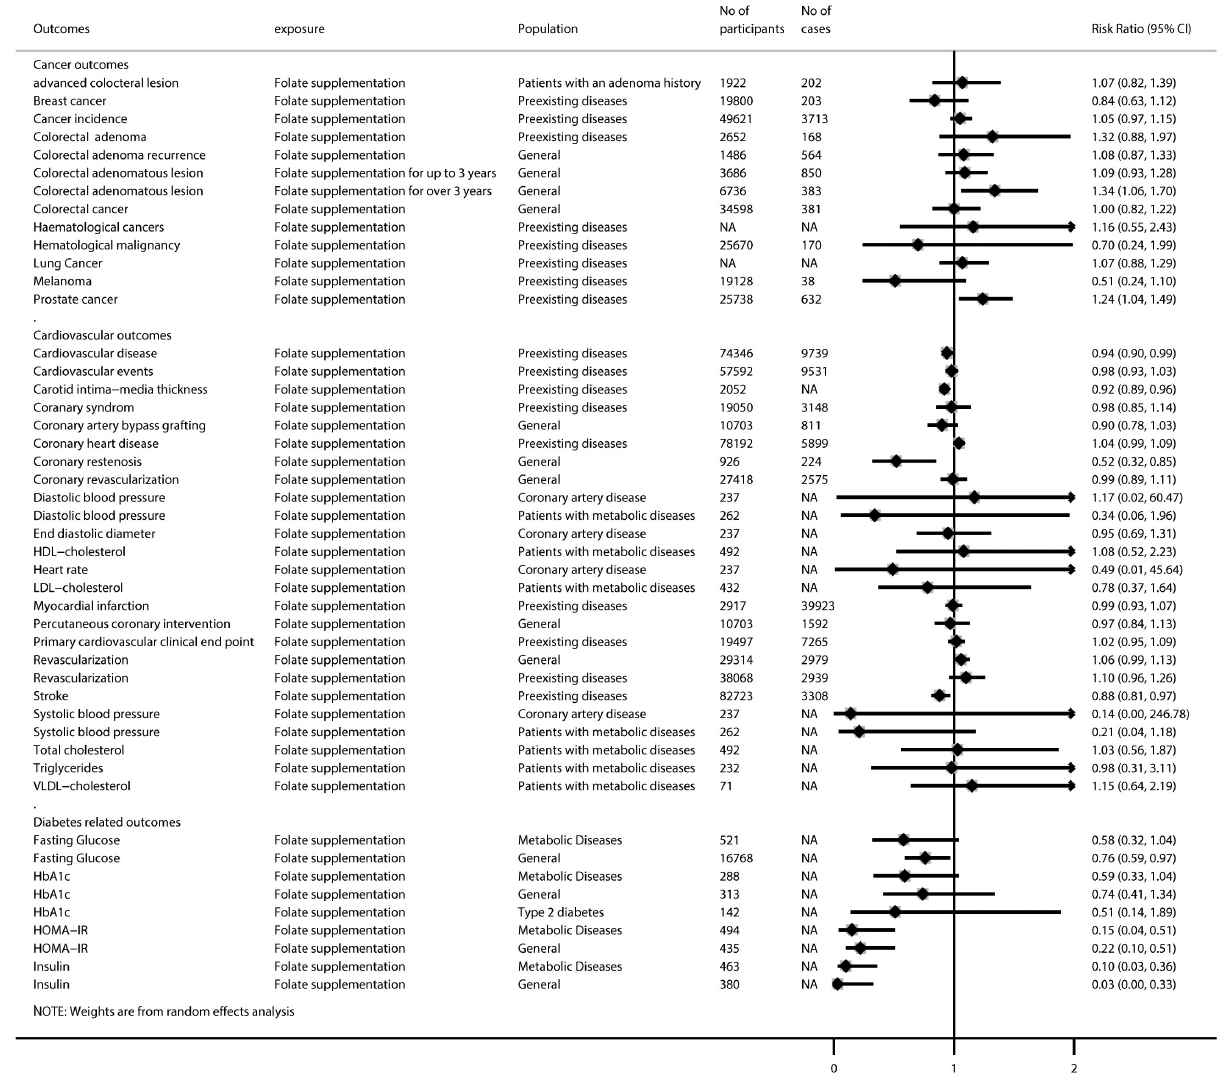
FIGURE 5 | Summary random-effects estimates of cancer outcomes, cardiovascular outcomes, and diabetes-related outcomes reported in meta-analyses of randomized controlled